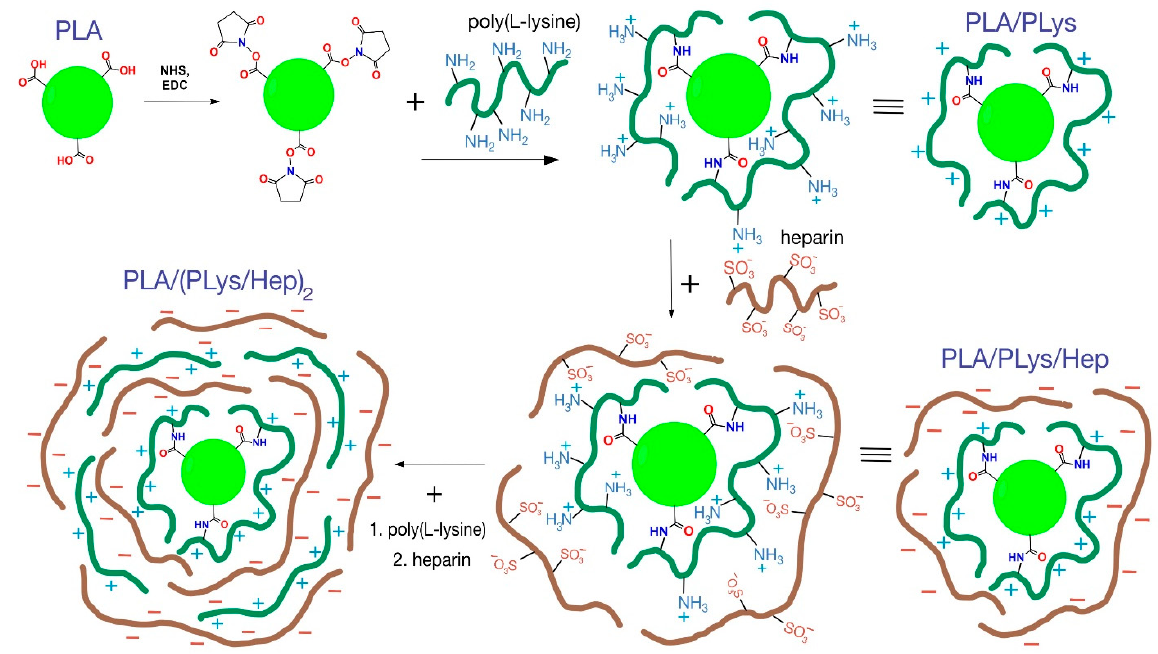
Figure 1. Scheme of particle modification by PLys and Hep. Note: The scales of particles and layers are not correct. The scheme shows the principal processes of particle modification.